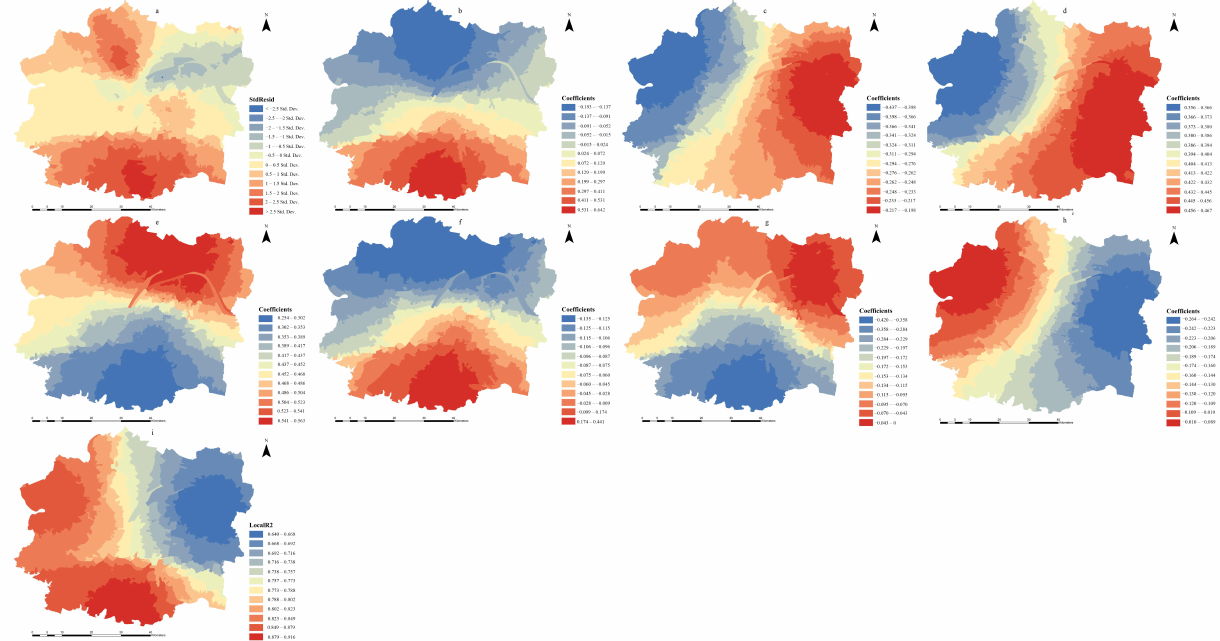
Figure 5. Deviance residuals of the GWR ( a ), spatial distributions of the regression coefficients: the distance to the city center ( b ), the number of other hospitals near each hospital ( c ), the number of people covered by each hospital ( d ), the number of hospital beds ( e ), the number of medical practitioners ( f ), the number of outpatient visits ( g ), the number of emergency visits ( h ), and the local R 2 of GWR ( i